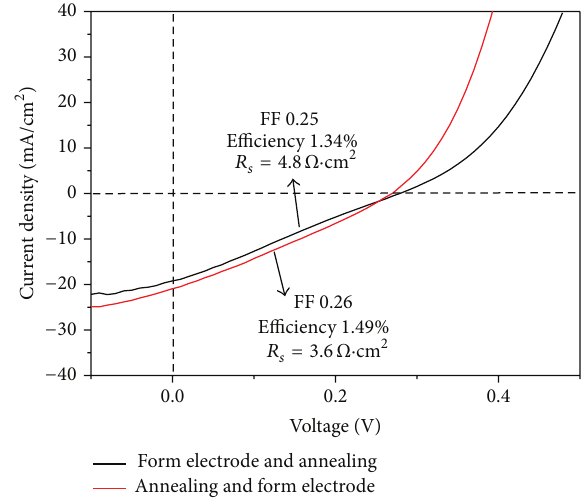
Figure 3: The illuminated J-V curves of the Gr-Si solar cells fabricated by different process